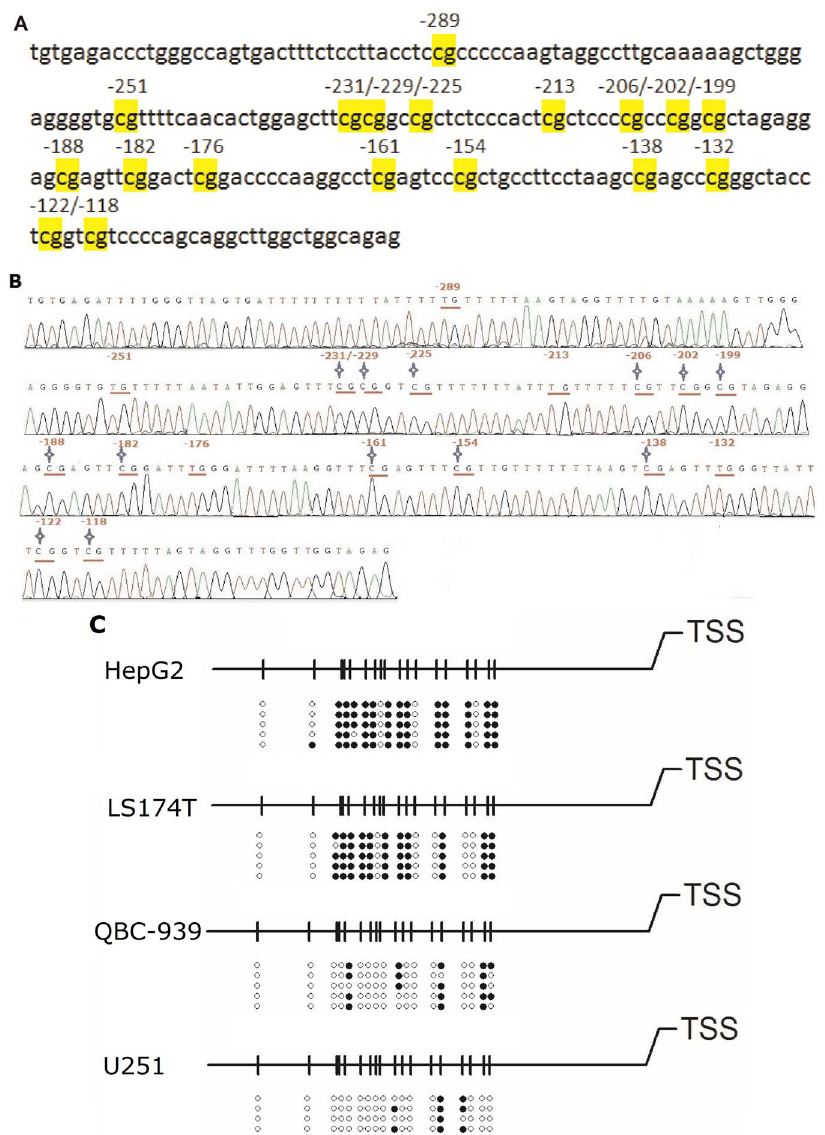
Figure 5. Methylation profiles around the transcriptional start site of OCTN2 . (A), the genomic sequence spanning 2 325 to 2 92 bp in promoter Region-1 of OCTN2 . Eighteen CpG sites were located and marked. (B), bisulfite genomic sequencing analysis of Region-1 of OCTN2 in HepG2 cells. Bisulfite modified DNA was amplified by BSP as described under Materials and methods and then sequenced. Pointed star represents methylated CpG sites. (C), DNA methylation profiles of individual methylated CpG dinucleotides in four cancer cell lines. After BSP, five clones were randomly selected and sequenced. The methylated sequences were checked for alignment using MethBLAST. The open and closed circles represent unmethylated or methylated cytosines,